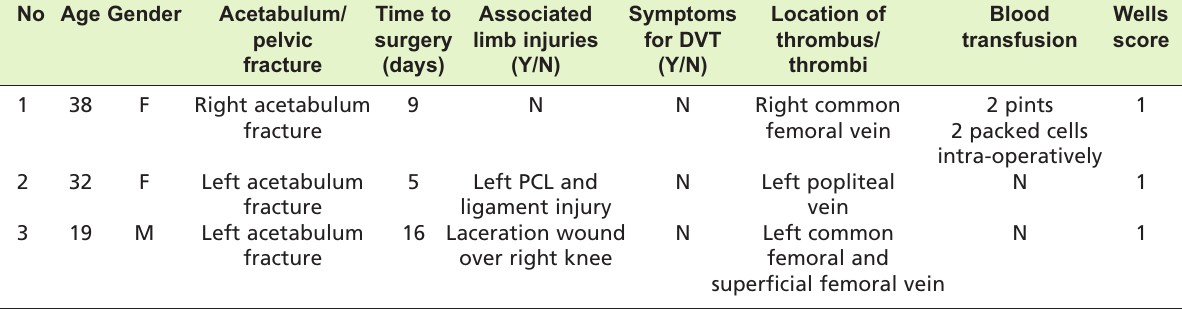
Patients with DVT during preoperative screening Table III: